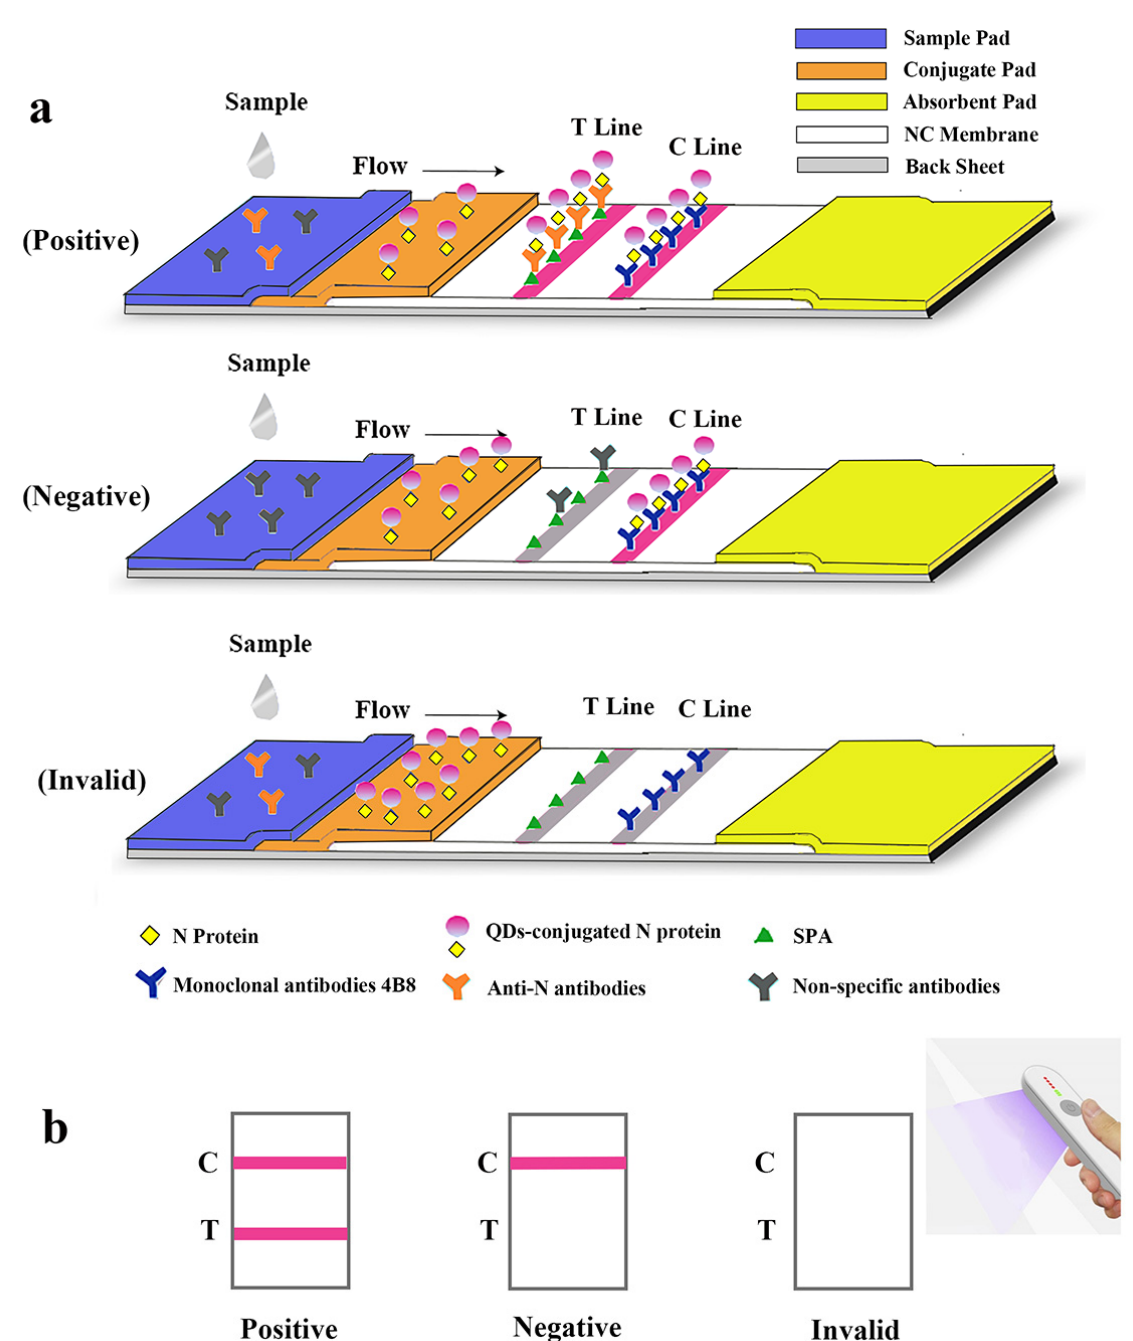
Figure 3. Schematic illustration of the lateral flow assay for the rapid detection of antibodies against SARS-CoV-2 N protein. ( a ) Schematic diagram of the detection device. ( b ) Interpretation of different testing results under UV light. “C” and “T” refer to the control line and the test line, respectively.